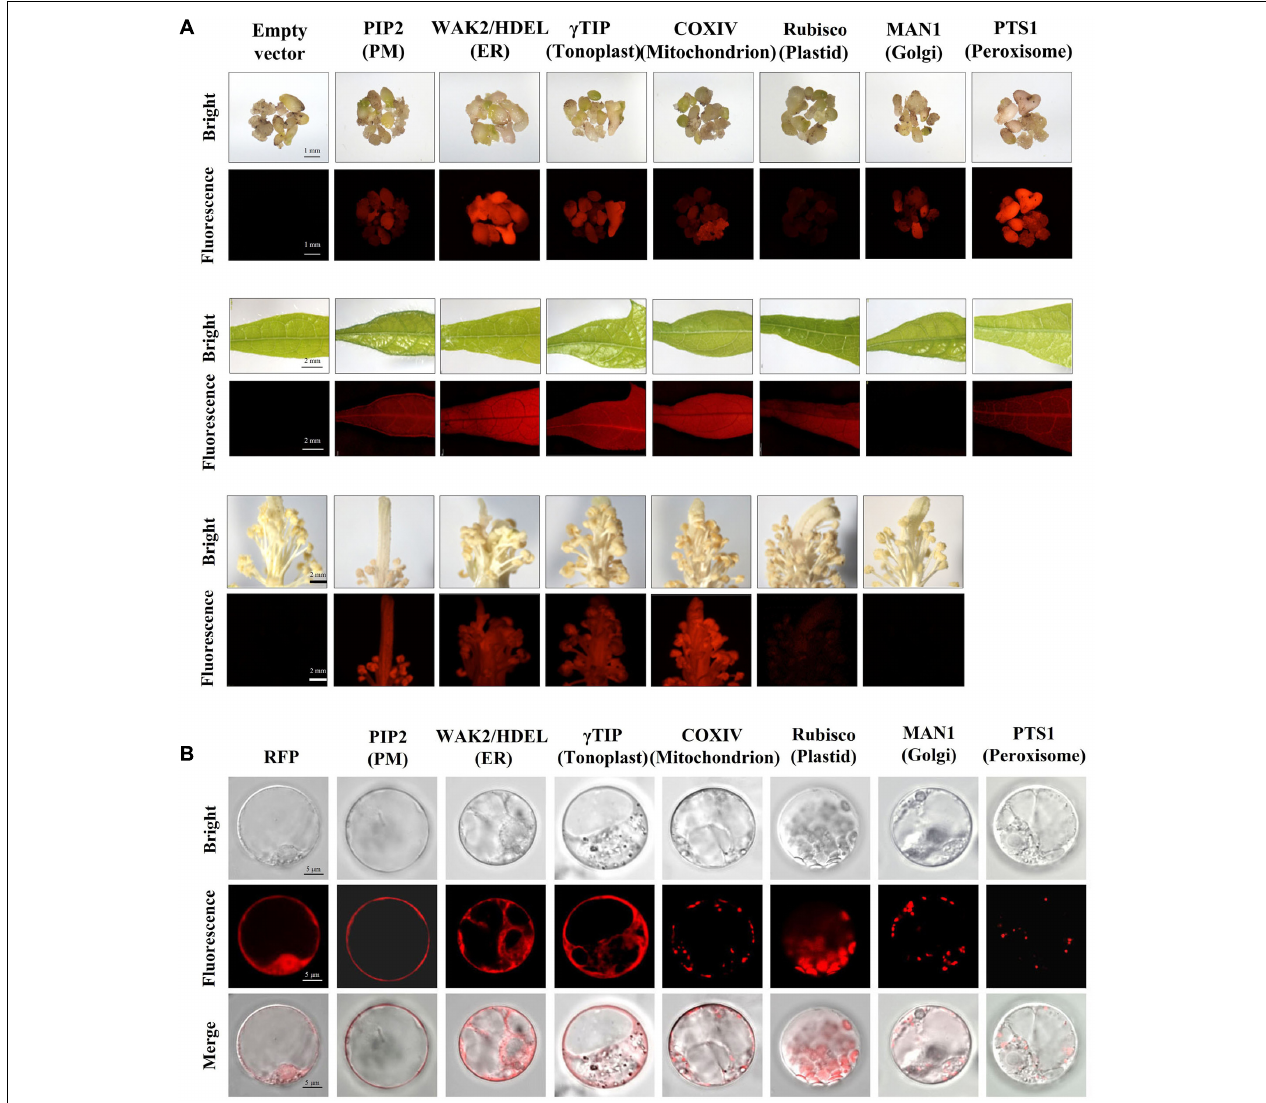
FIGURE 7 | Transgenic cotton expressing in vivo organelle markers. (A) The transgenic embryo, leaf, and stamen/pistil expression of mCherry-fused organelle markers exhibited red fluorescence under white light (bright) and excitation light (fluorescence). Empty vector transformants were used as a negative control; scale bars: 1 mm in embryo observations, 2 mm in leaf and stamen/pistil observations. (B) Characteristic features of organelles in cotton protoplasts. The protoplast isolated from transgenic materials overexpressing mCherry as a positive control; scale bar, 5 µ m. PM, plasma membrane; ER, endoplasmic